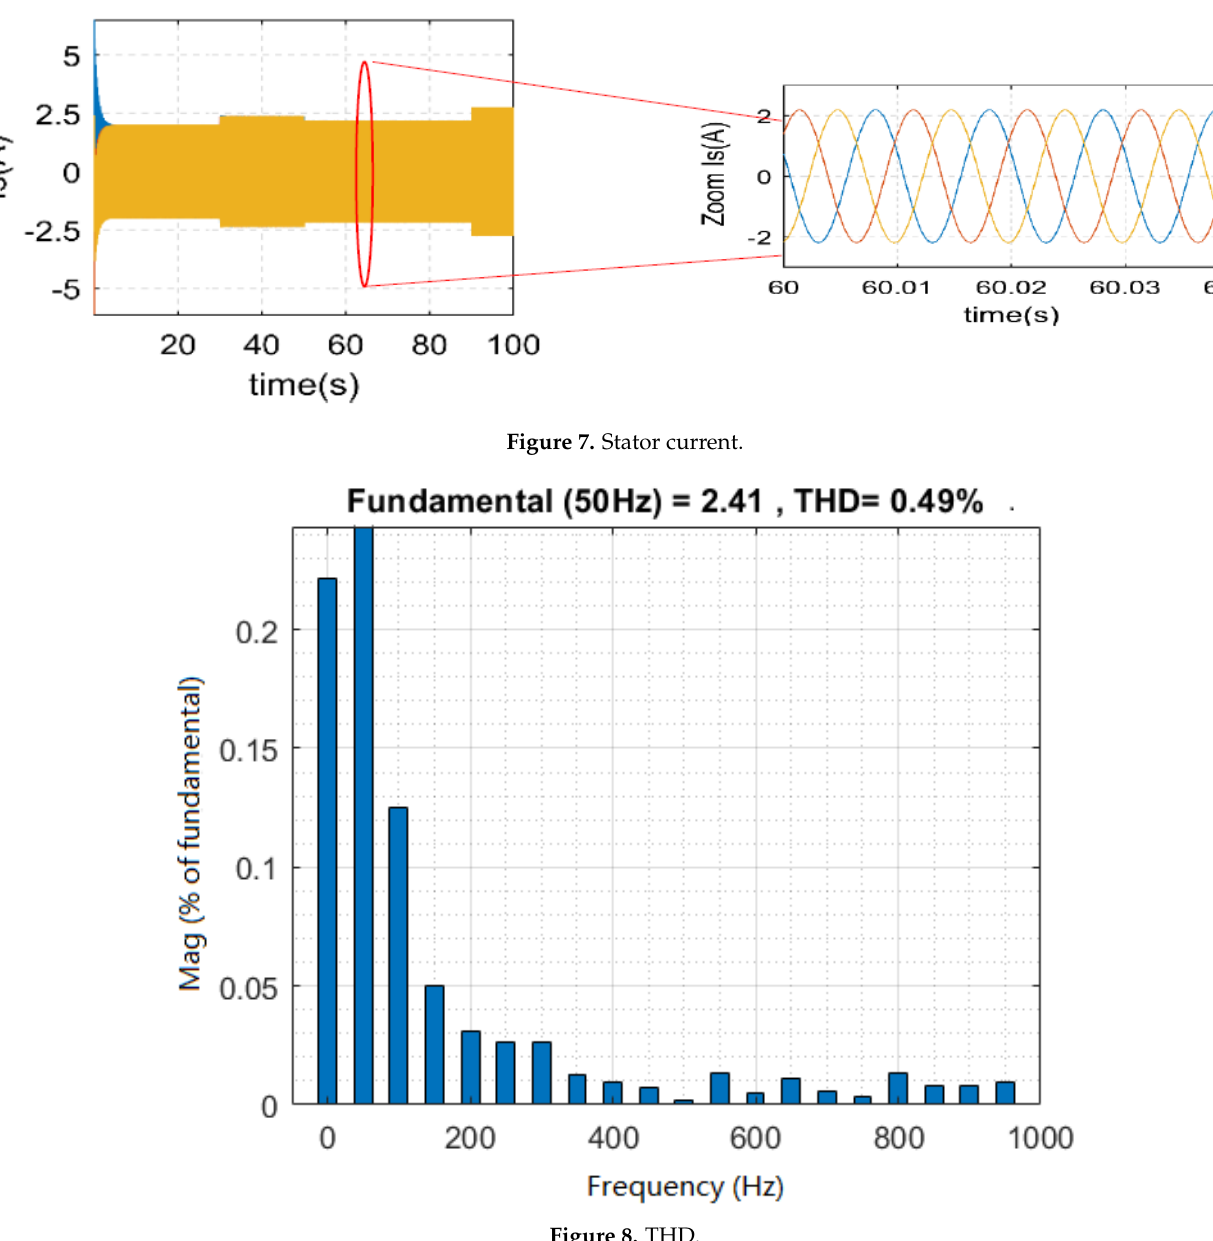
Figure 6. Direct and quadrature rotor current.